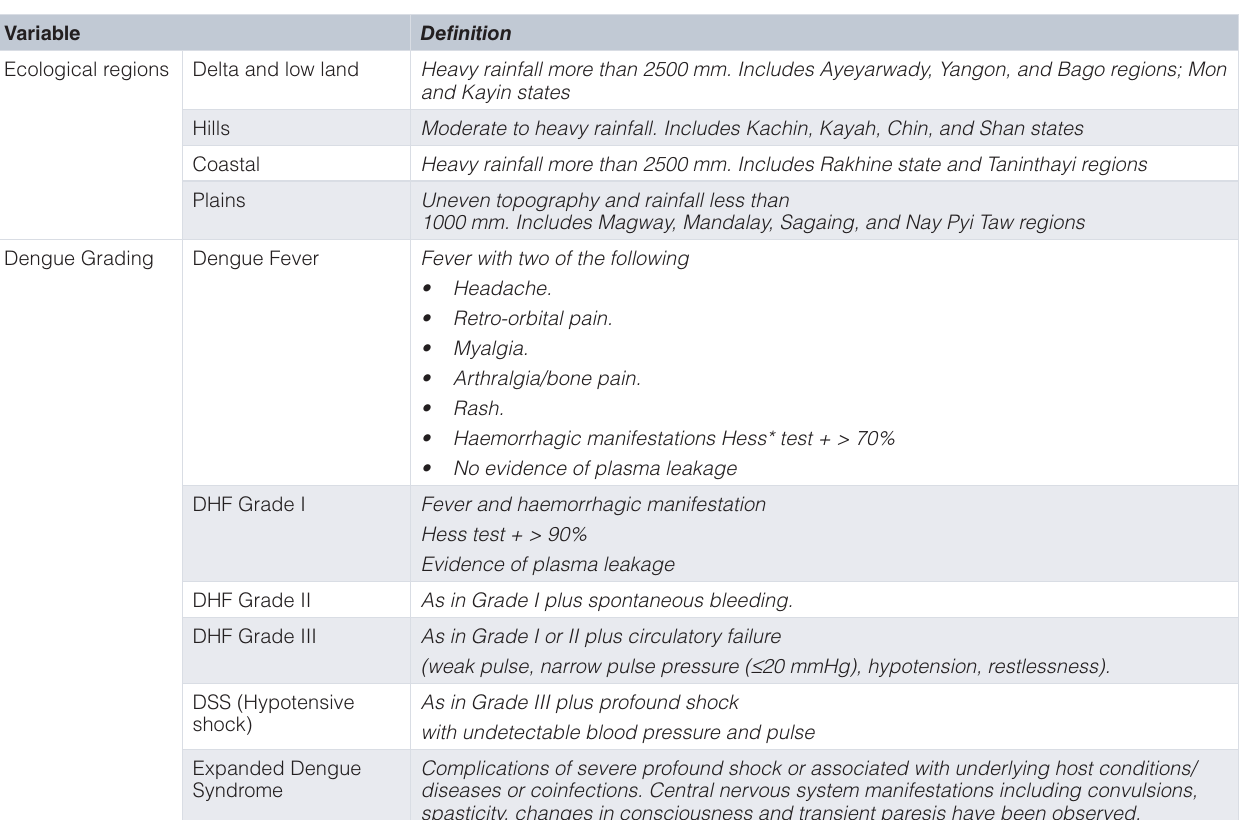
Table 1. Operational definitions used in this study 3,13,18 .